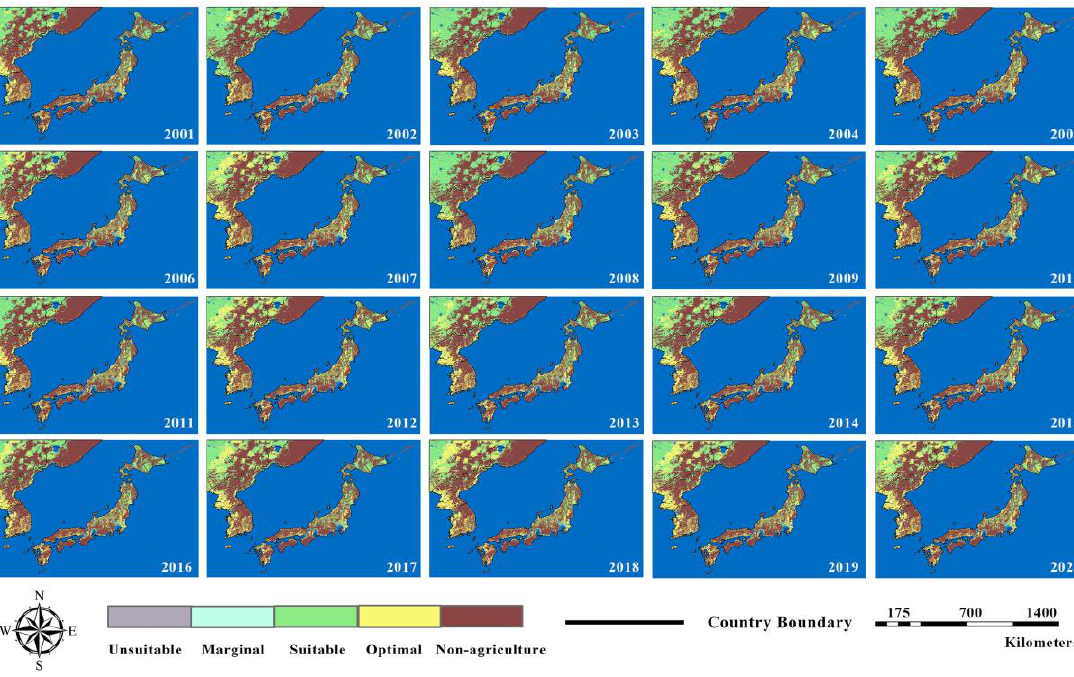
Figure 5. Bio-geophysical suitability maps of East Asia from 2001 to 2020 in autumn.